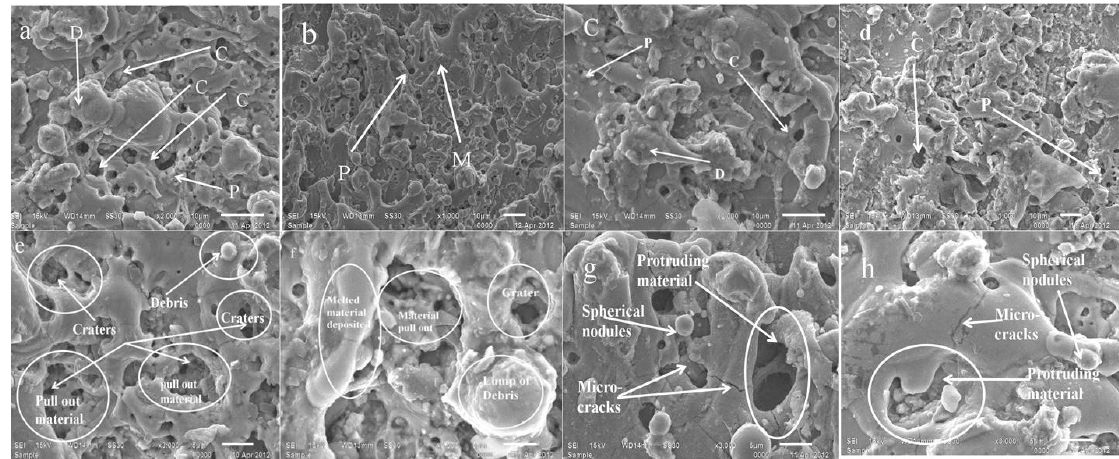
Figure 6: SEM micrographs observed with C → Craters, P → Pockmarks, D → Debris, M → Matt surface, spherical nodule, and protruding material at higher POT=1.1 µ s, POFT=17 µ s and PC=200A.